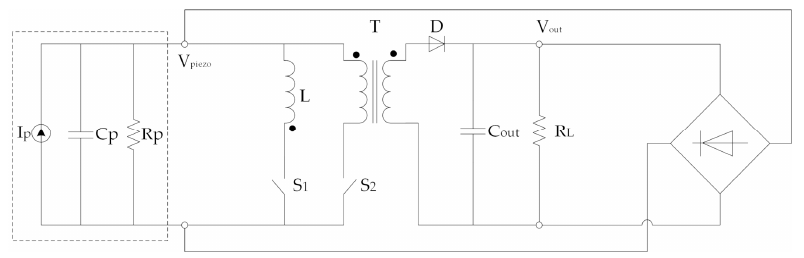
Figure 50. The Hybrid SSHI rectifier circuit.